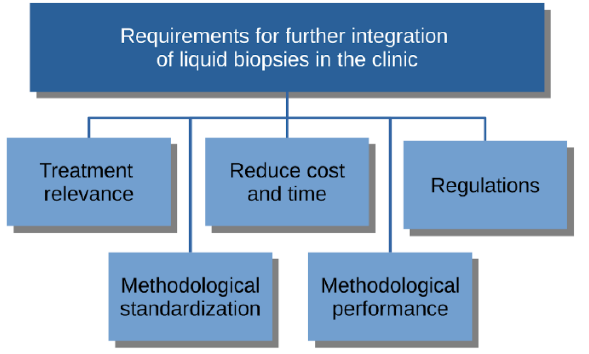
Figure 1. Overview of the most important identified requirements for further integration of liquid biopsies in the clinic.